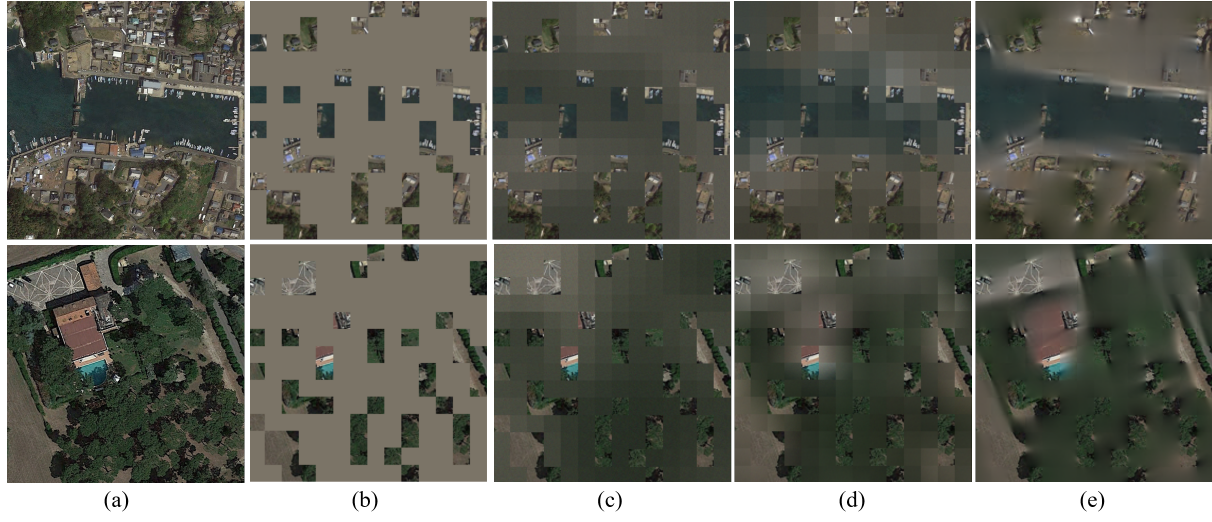
Figure 4. Reconstructed examples on AID [19] images. ( a ) denotes the original images; ( b ) denotes masked images; ( c ) denotes reconstructed results of pre-trained model at the 10th epoch; ( d ) denotes reconstructed results of pre-trained model at the 50th epoch; ( e ) denotes reconstructed results of pre-trained model at the 800th epoch. Obviously, the reconstruction quality from ( c ) to ( e ) becomes better and